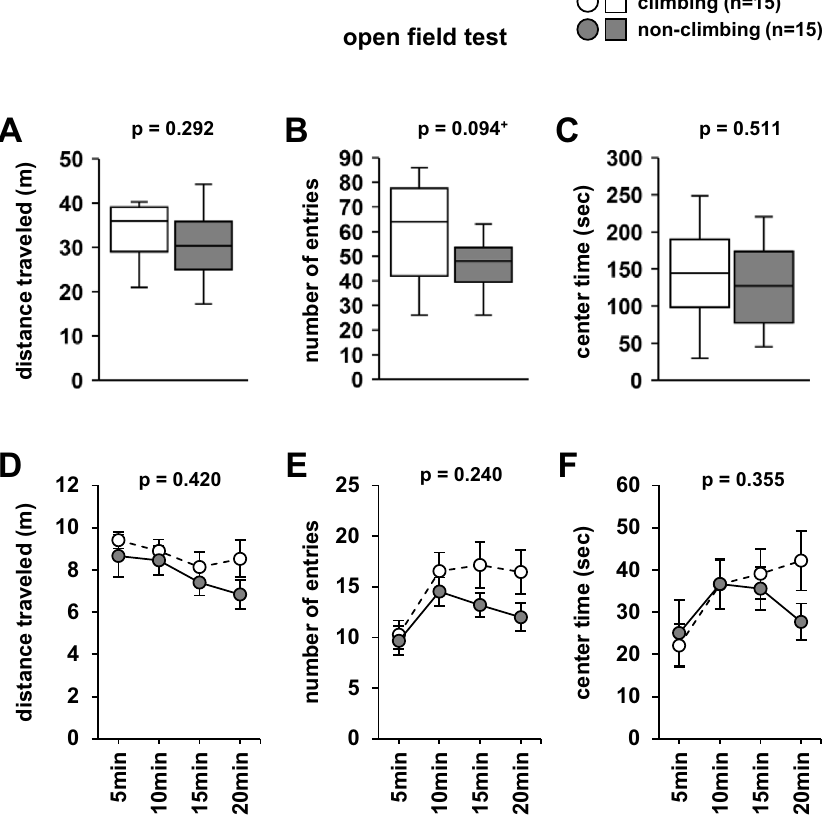
Figure 6. The effect of grid-climbing prevention on the performance in the open field test. Graphs displaying the total distance travelled ( A ), total number of entries into the central area ( B ), total time spent in the central area ( C ), distance travelled in each 5 min period ( D ), number of entries into the central area in each period ( E ), and time spent in the central area in each period ( F ). Data are presented as box plots ( A – C ) or mean ± standard error ( D – F ). Statistical significance is represented by asterisks: * p < 0.05, + p < 0.1. P -values were calculated